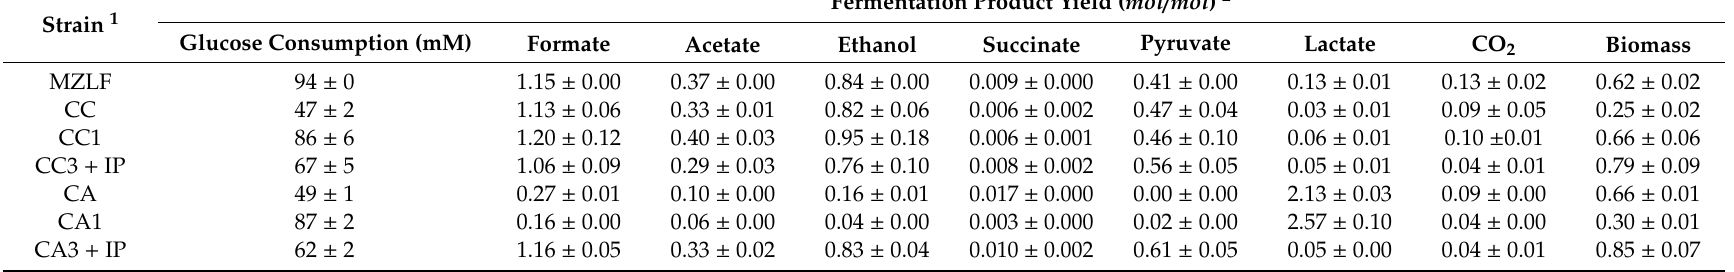
Table 3. Glucose consumptions and fermentation product yields of bacterial strains tested in this study. The standard deviation was used for the error with n (biological replicates) ≥